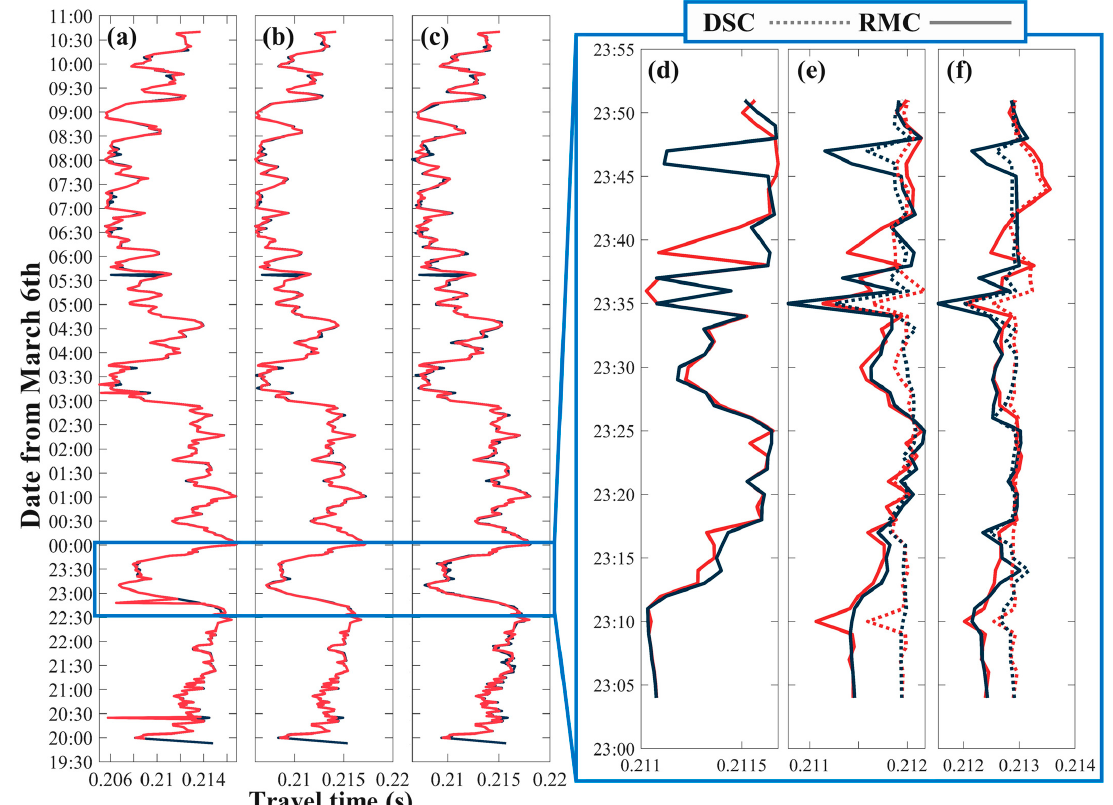
Figure 7. Travel time correction of S1 to S3 via two methods. ( a – c ) are the initial travel time results of first peak, second peak, and third peak during the entire sampling period, respectively. Red lines denote the transmission from S1 to S3, and black lines denote the transmission from S3 to S1. ( d – f ) are the corrected travel time of first peak, second peak, and third peak via the two methods (direct signal transmission correction and ray-model position correction), respectively. The dotted lines denote DSC, and real lines denote RMS. Table 1 shows the standard deviation comparison of multi-peak travel time before and after the correction. The comparison of standard deviation also verifies the feasibility of the two methods. Both methods have advantages and disadvantages: DSC is faster and simpler, and RMC is more complex and keeps more information of signal variations. Table 1. Standard deviation comparison of initial and correction travel times.